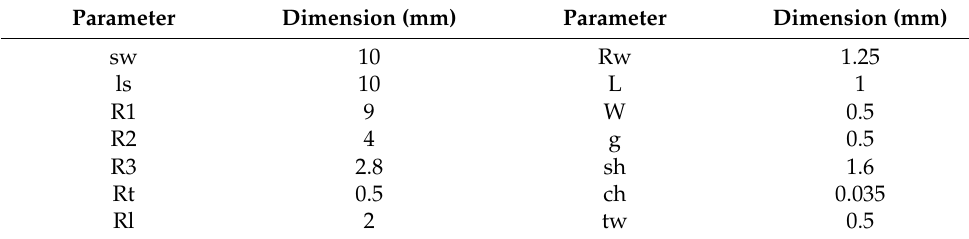
Figure 1. Proposed ISMeTM: ( a ) unit cell configuration; ( b ) simulated model. Table 1. Parameter of the ISMeTM unit